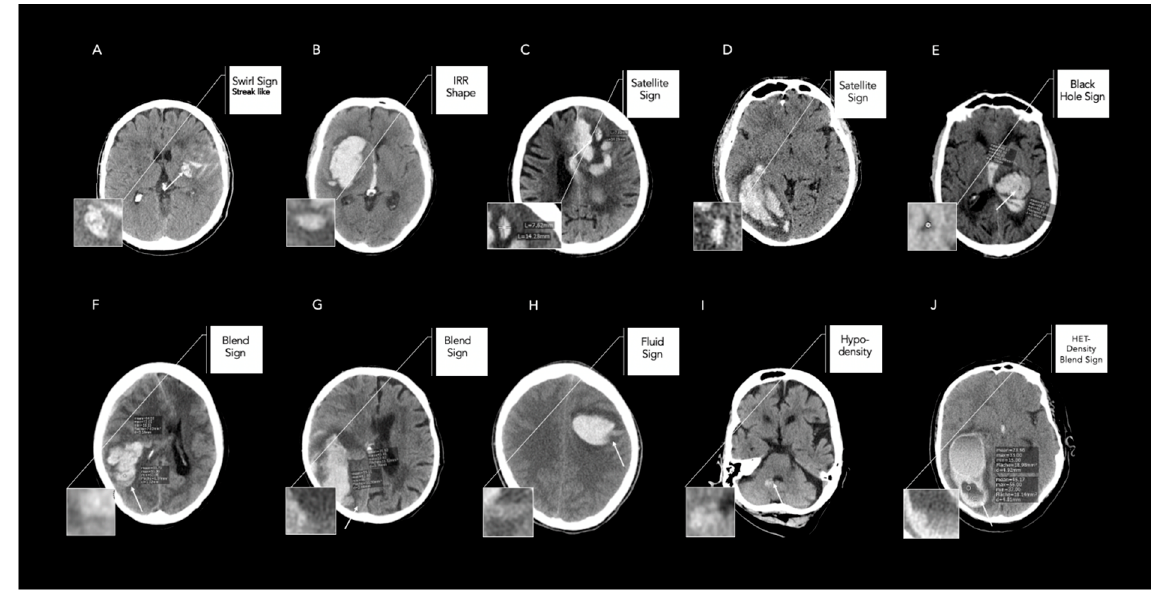
Figure 1. Illustrative examples of false-positive and -negative rated Noncontrast Computed Tomog- raphy (NCCT) markers between different raters. Legend: Illustrative examples of interpretation of Noncontrast Computed Tomography markers with maximal discordances between one radiology resident, one radiology fellow, and one neuroradiology fellow. ( A ) Streak-like swirl sign was rated false negative by the resident. ( B ) IRR shape rated false negative as Barras II versus qualifying as Barras III by the neuroradiology fellow. ( C ) Satellite sign rated false negative, with a diameter greater than 10 mm, as shown by the neuroradiology fellow’s measurements. ( D ) Satellite sign rated false positive, as the small hematoma shows signs of connection with the main hematoma according to the fellow. ( E ) Black-hole sign rated false positive, with encapsulated hypodensity but density differences less than 28 HU, as shown by the neuroradiology fellow’s measurements. ( F , G ) Blend sign rated false positive, with well-defined margins of density changes within the hematoma but density differences less than 18 HU, as indicated by the neuroradiology fellow’s measurements. ( H ) Fluid sign rated false positive with a discrete straight line above the hyperattenuating area which is not clearly separated by a hypoattenuating area of hemorrhage or edema. ( I ) hypodensity rated false positive as no strict encapsulation was defined by the neuroradiology fellow. ( J ) HET density rated correctly by two raters. Fluid sign was rated by neuroradiology fellow. In contrast, blend sign was rated false positive, with density measurements less than 18 HU, by the resident. Table 4. Agreement of Noncontrast Computed Tomography markers across one gold rater stratified with Cohen’s kappa.